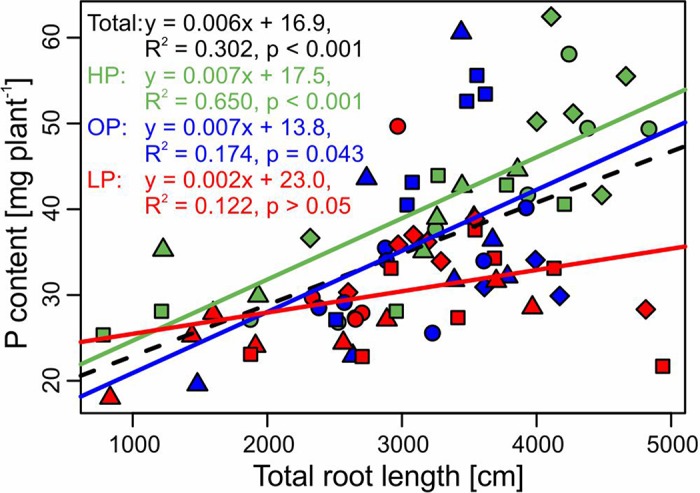
Relationship (linear regression) between P content and total root length of the potato cultivars Amsel (circle), Gesa (square), Paterson’s Victoria (diamond), and Weinberger Schloßkipfler (triangle) fertilized with KH2PO4 (HP, green), C6H16CaO24P6 (OP, blue), or without P supply (LP, red) and across all fertilizers (black, dashed line). Regression equations, multiple R
2 and p values are given. Individual symbols are individual plants.